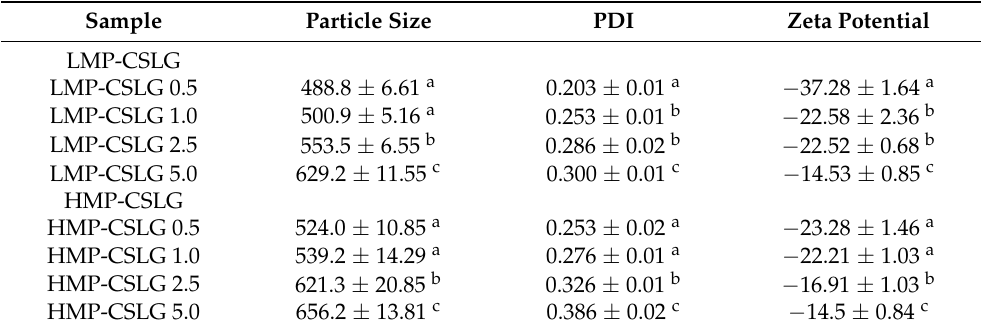
Table 2. Particle size, PDI, and zeta potential of LMP-CSLG and HMP-CSLG complex